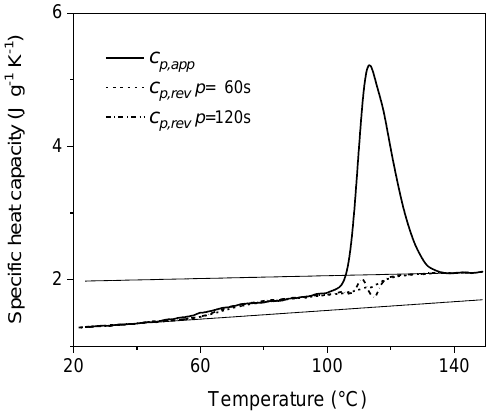
Figure 19. Apparent specific heat capacity ( c p,app : solid lines) of PLLA and reversing specific heat capacity ( c p,rev ) on cooling at 2 K min −1 as a function of temperature ( p = 60 s: dashed line; p = 120 s: dashed dotted line). The thin solid lines are the thermodynamic solid and liquid specific heat capacities of PLLA as taken from the literature [45]. (Reprinted (adapted) with permission from [79]. Copyright (2017) Springer).